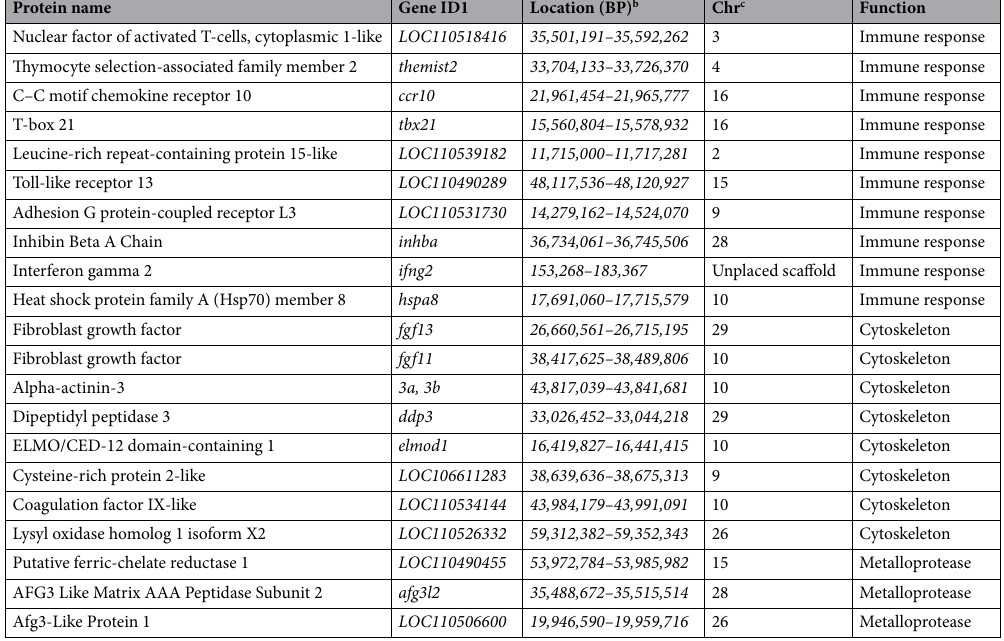
Table 4. Candidate genes for sea lice resistance in rainbow trout . a Gene identification (Gene ID) from the NCBI database GenBank assembly accession: GCA_002163495.1. b Location in base pair (bp). c Chromosome